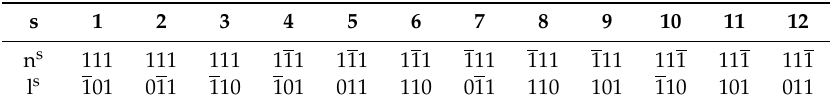
Table 2. The primary slip systems of single crystal silicon [26].